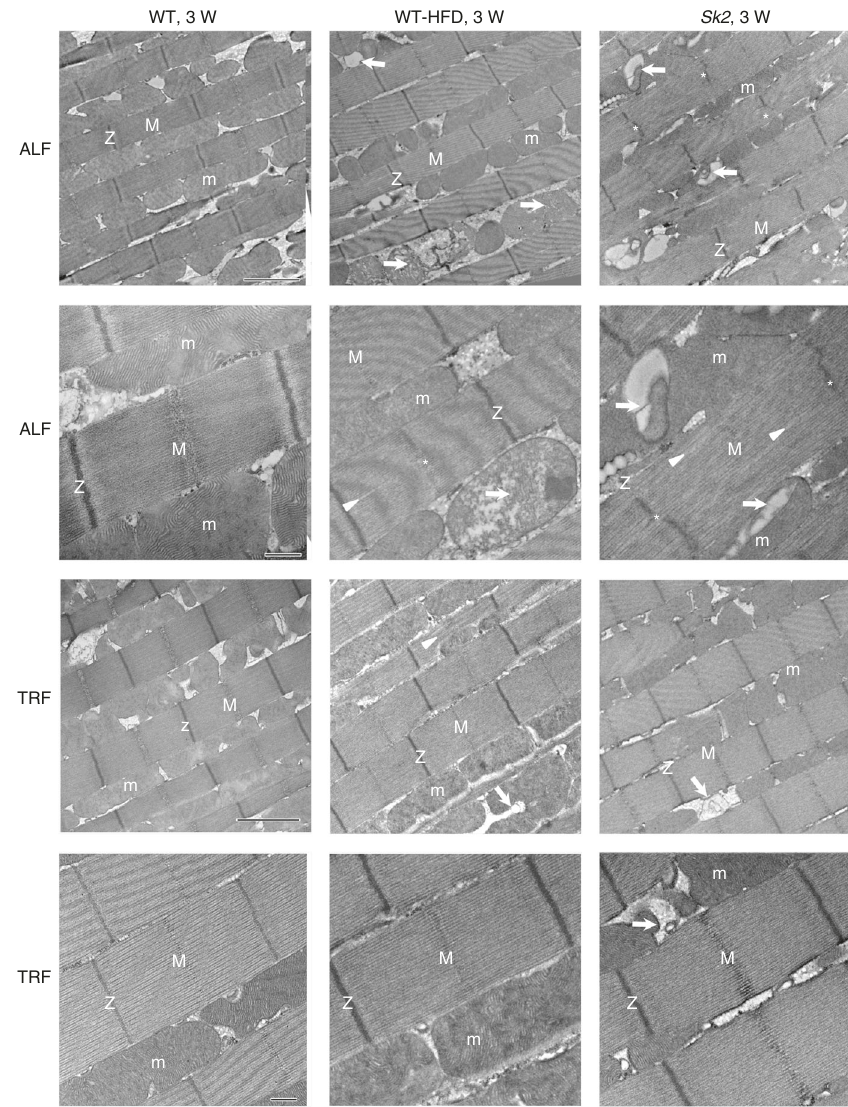
Fig. 7 TRF suppressed obesity-induced myo fi brillar and mitochondrial defects at the ultrastructural level. Ultrastructural analysis using TEM revealed that obesity caused myo fi bril disorganization and mitochondrial abnormalities compared with wild-type CS under ALF in 3-week-old female fl ies IFM. Compared with control (left top two panels), occasional myo fi brils with partially intact Z-disks (Z) and M-lines (M) were observed (middle top two panels, asterisks and arrowheads) with the diet-induced obesity which were more prominent in the genetic obesity mutant (right top two panels, asterisks and arrowheads). The abnormal mitochondria (m) were evident with diet and genetic obesity partially or completely degenerated cristae (arrows). Scale bars for the top and bottom panels under ALF are 2 µ m and 0.5 µ m, respectively. Myo fi brillar and mitochondrial abnormalities were signi fi cantly ameliorated under TRF in both obesity models. Scale bars for the top and bottom panels under TRF are 2 µ m and 0.5 µ m, respectively. Most of the images of the diet and genetic obesity model look like wild-type under TRF. The quanti fi cation of myo fi brillar and mitochondrial associated with obesity are shown